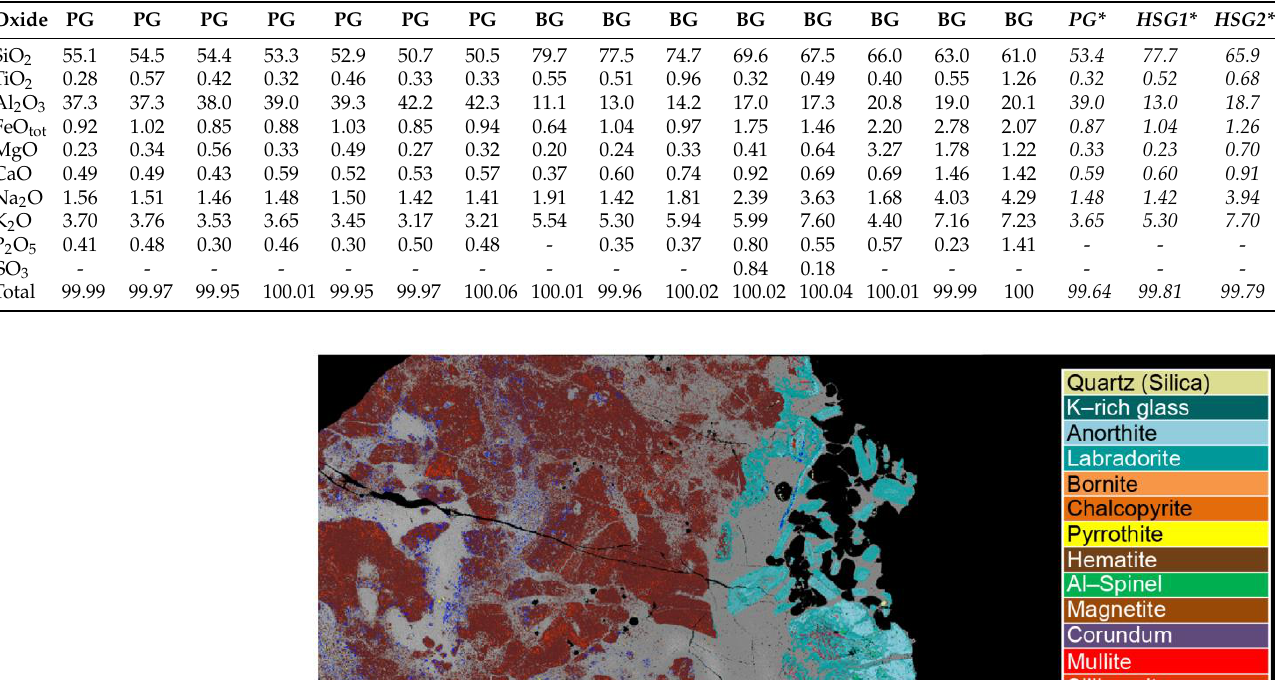
Table 1. FESEM EDS analyses of porcellanite glass (PG) and buchite glass (BG) of B1 xenolith. The three last columns repre- sent the reference composition of the three glasses’ population (mean) of the glass (using 2 µ m spots) for the QEMSCAN TM map of Figure 4: PG* : porcellanite glass mean population; HSG1* : High silica glass, mean population 1 in the buchite; HSG2* : High silica glass, mean population 2 in the buchite.